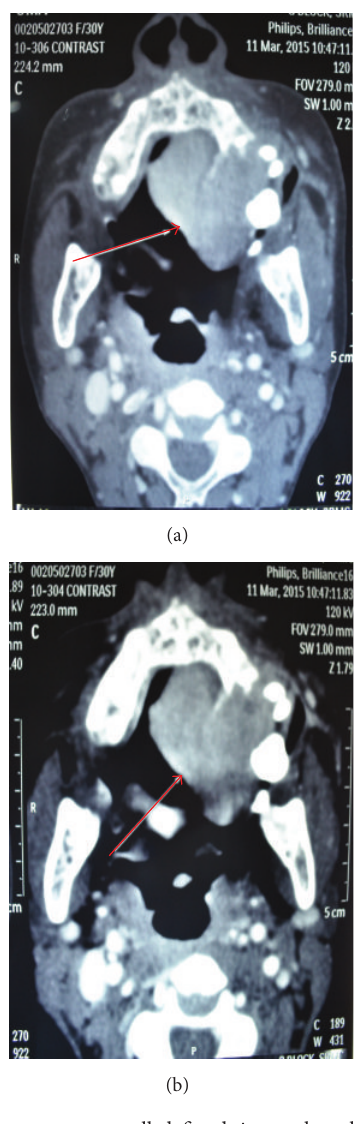
Figure 2: Proliferative growth of size 6cm × 5 cm with irregular margins, extending from the 24 region up to the posterior part of the hard palate crossing the midline.